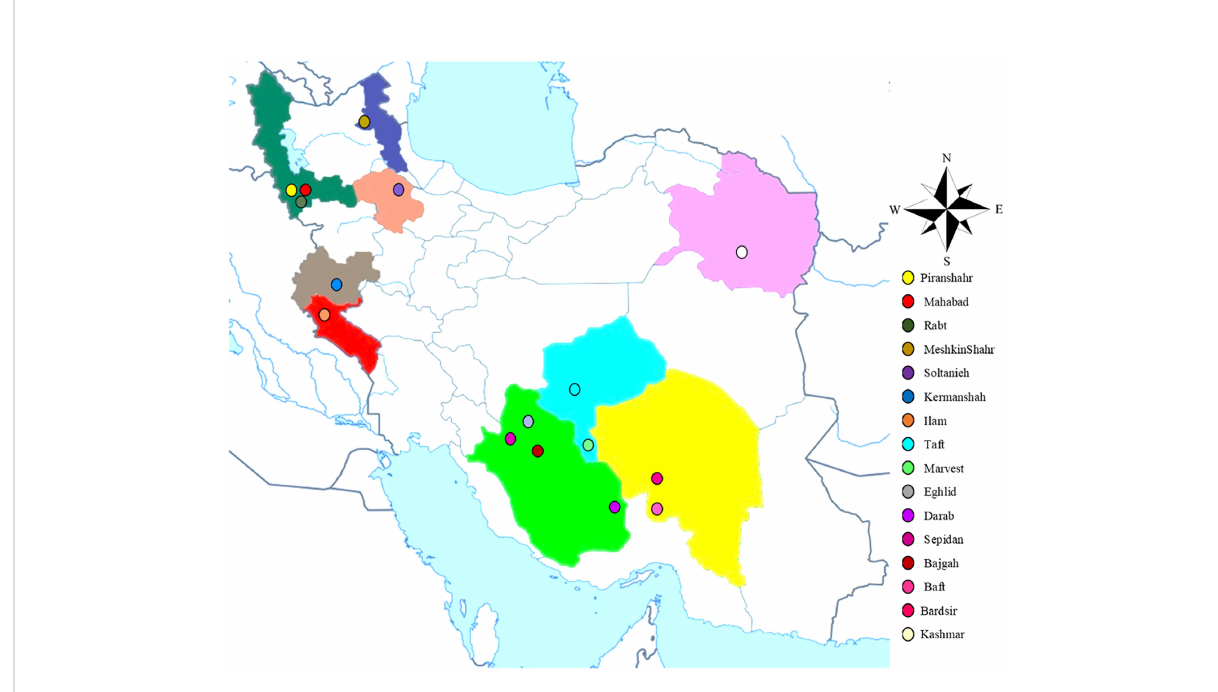
FIGURE 1 The collection areas for the investigated accessions of G. glabra